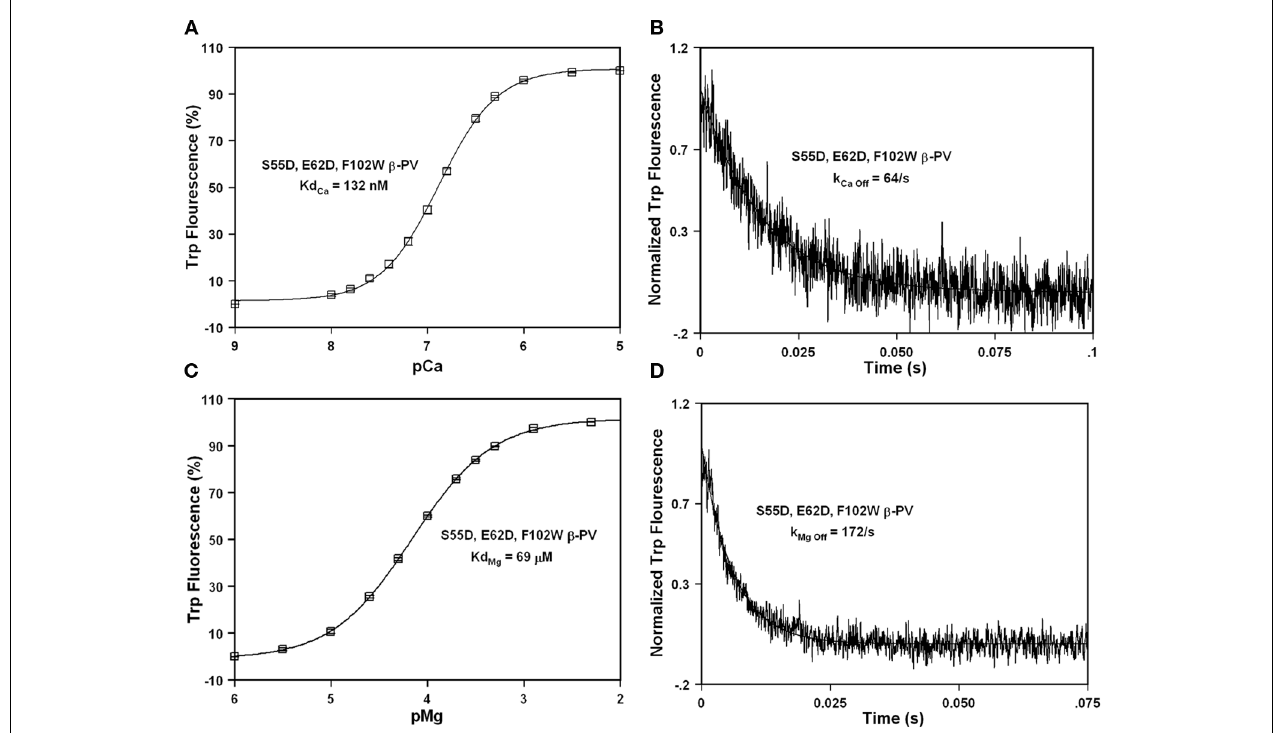
FIGURE 6 | Ca 2 + and Mg 2 + binding and dissociation from S55D, E62D, F102W β -PV. (A) The Ca 2 + dependent increase inTrp fluorescence is shown as a function of − Log[Ca 2 + ] (pCa) for S55D, E62D, F102W β -PV. (B) The time course ofTrp fluorescence is shown as EDTA rapidly chelates Ca 2 + causing dissociation of Ca 2 + from S55D, E62D, F102W β -PV. (C) The Mg 2 + dependent